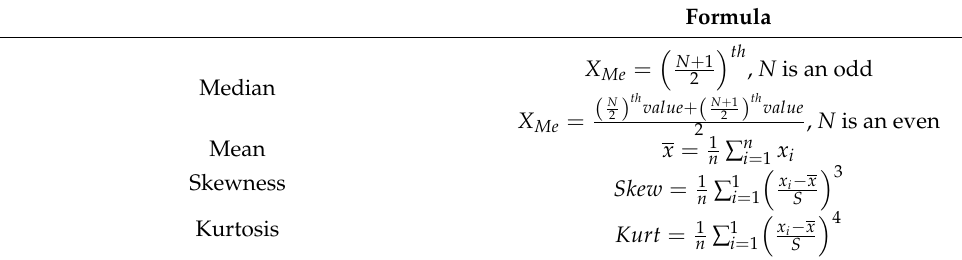
Table 1. Calculation formula linear